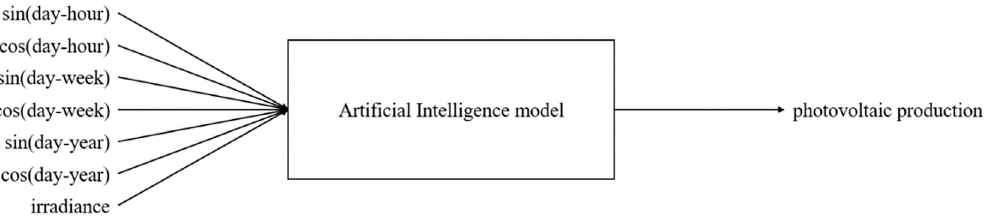
Figure 5. Photovoltaic production forecasting problem, where the Artificial Intelligence model corresponds to the considered Machine Learning or Deep Learning model.